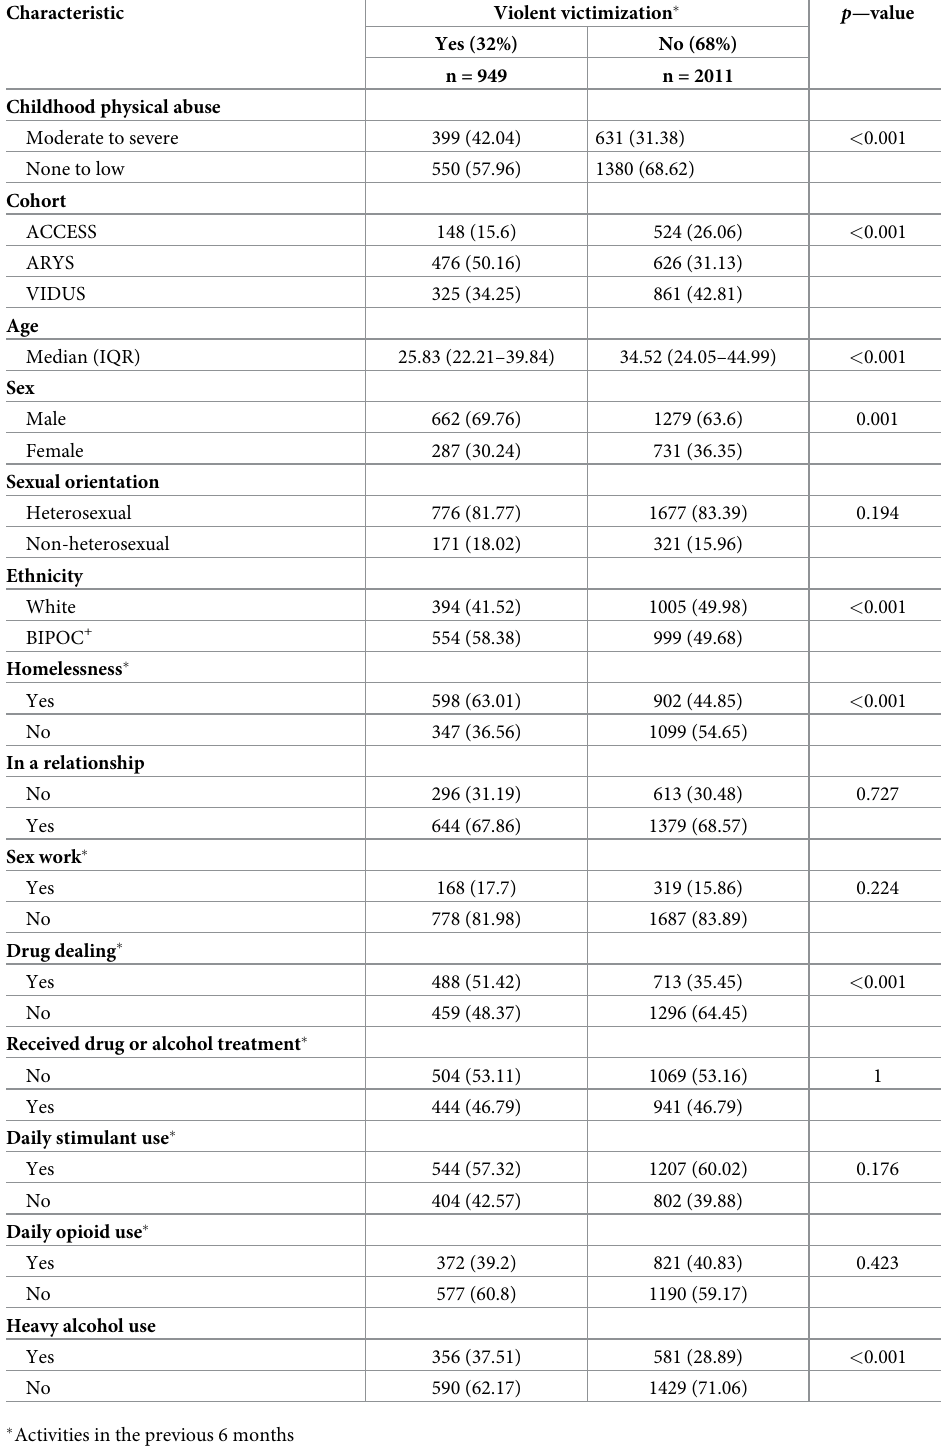
Table 1. Baseline characteristics of people who use illegal drugs in Vancouver, Canada, stratified by violent vic- timization (N =